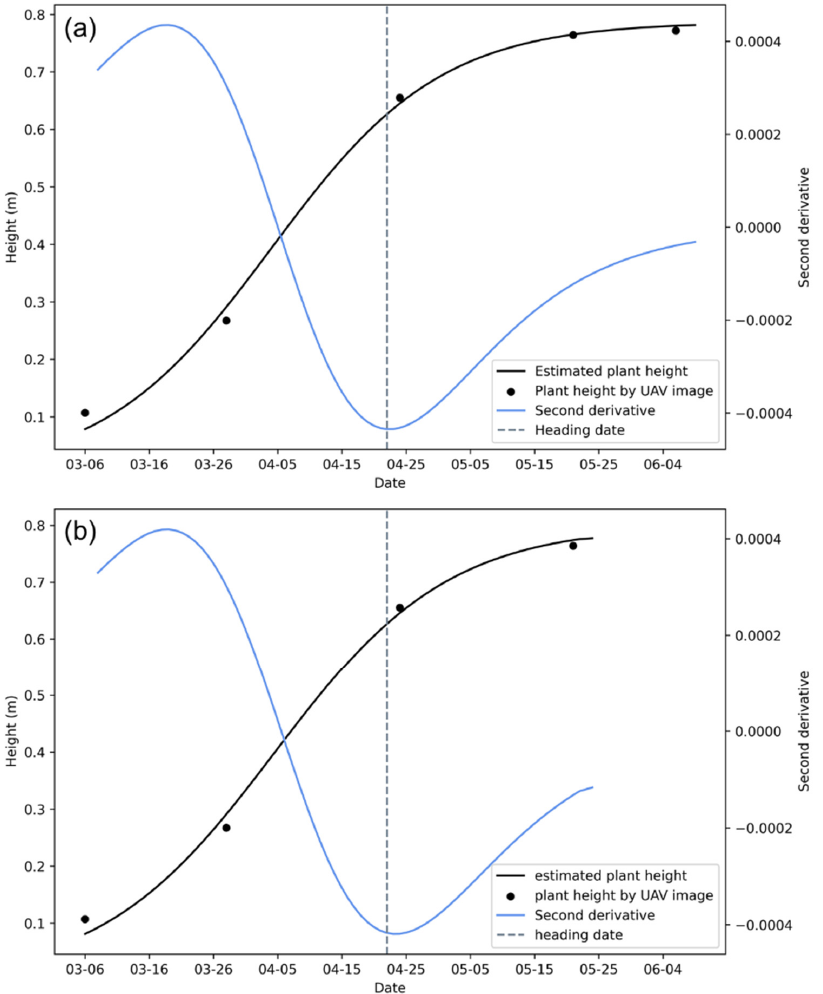
Figure 8. Growth curves and second derivatives of the plot (sowing date: 5 October; variety: Jimai 22; density: 4.5 million plants/ha). ( a ) Results obtained from the UAV images of all five-time series, ( b ) Results obtained from the UAV images of the first four-time series.